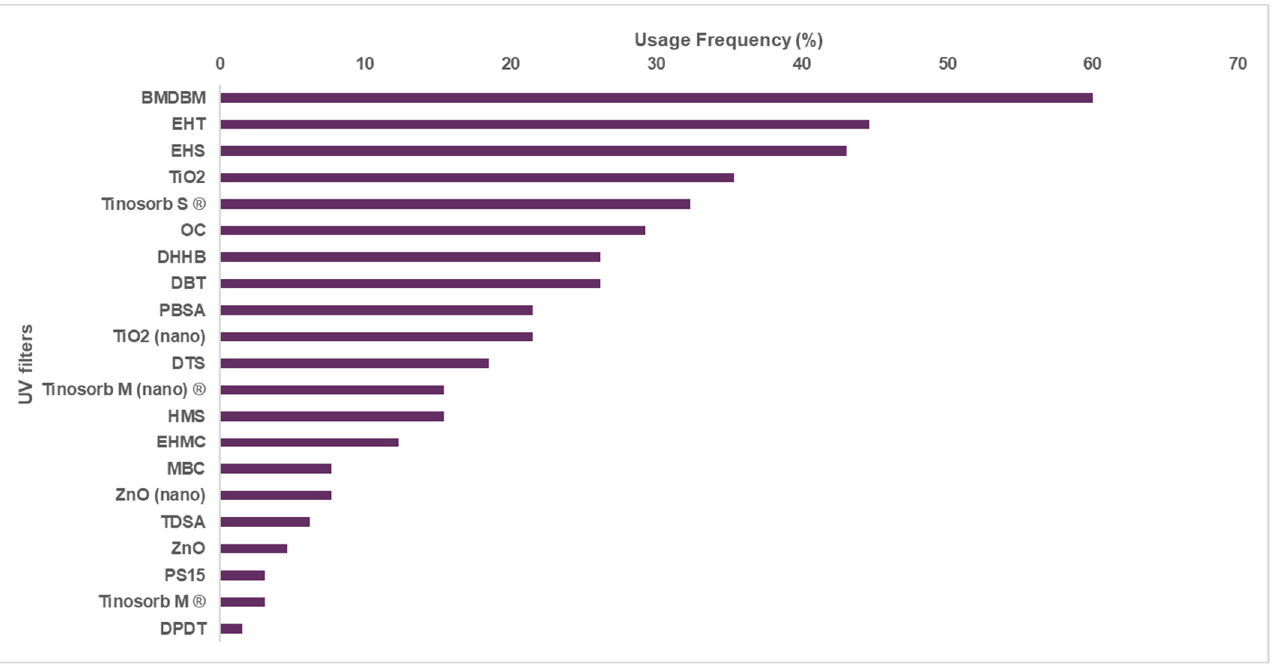
Figure 2. Frequency of use for the different UV filters in sunscreens for children. (BMDBM: butyl methoxydibenzoylmethane, EHT: ethylhexyl triazone, EHS: ethylhexyl salicylate, Tinosorb S ® : bis- ethylhexyloxyphenol methoxyphenyl triazine, OC: octocrylene, DHHB: diethylamino hydroxyben- zoyl hexyl benzoate, DBT: diethylhexyl butamido triazone, PBSA: phenylbenzimidazole sulfonic acid, DTS: dometrizole trisiloxane, HMS: homosalate, EHMC: ethylhexyl methoxycinnamate, MBC: 4-methylbenzylidene camphor, TDSA: terephthalydidene dicamphor sulfonic acid, PS15: polysilicone- 15, Tinosorb M ® : methylene bis-benzotriazolyl tetramethylbutylphenol, and DPDT: disodium phenyl dibenzimidazole